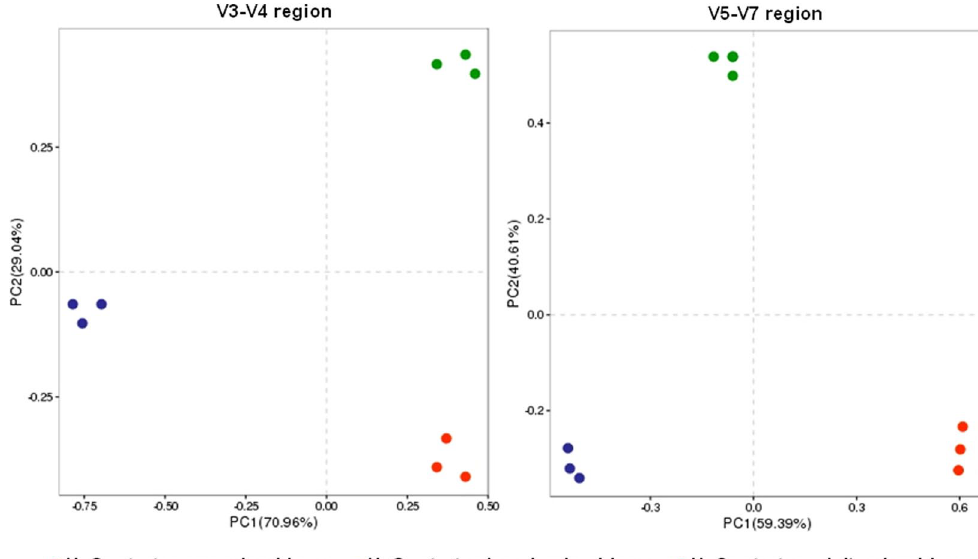
Figure 9. Principal coordinate analysis (PCoA) of H. contortus microbiome using primer pairs targeting V3– V4 ( A ) and V4–V5 ( B ) regions. The percentage variation explained with first two principal components (PC1 and PC2). Data represent average values from pooled populations (i.e. from each sheep) of eggs/larvae/adults (male and female) come from three different